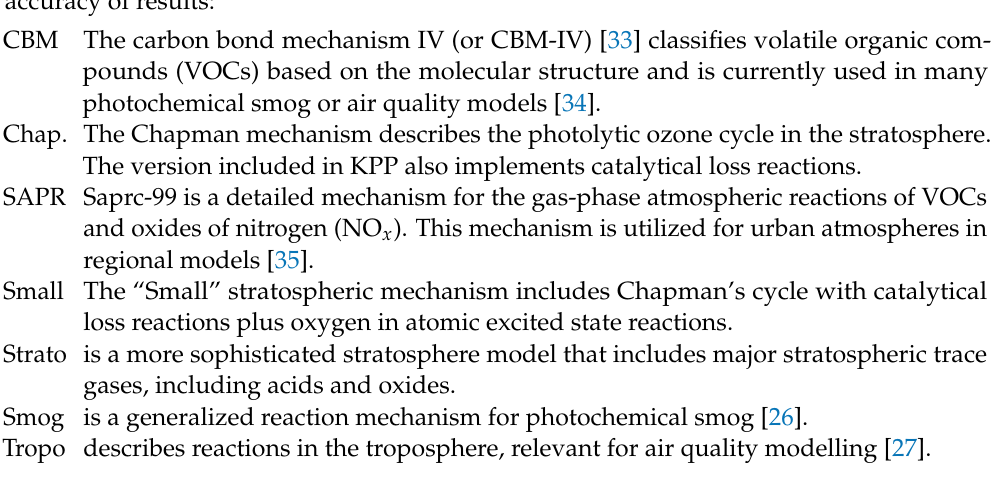
Table 1. Benchmarked chemistry